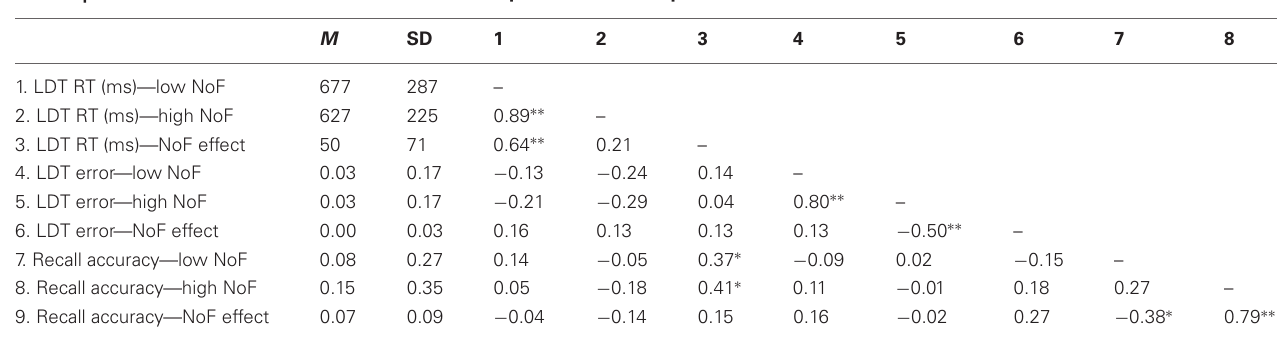
Table 4 | Means and intercorrelations for LDT and recall performance in Experiment